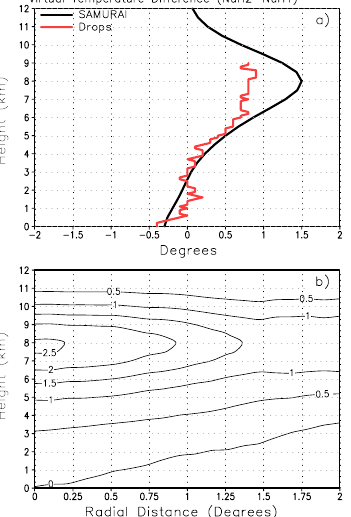
Figure 14. Vertical profile (a) of the mean virtual temperature difference over the observational domain from our SAMURAI analysis (black) and the dropwindsonde analysis of Montgomery and Smith (2012), red. Radius-height cross-section (b) of the azimuthally-averaged virtual temperature difference.